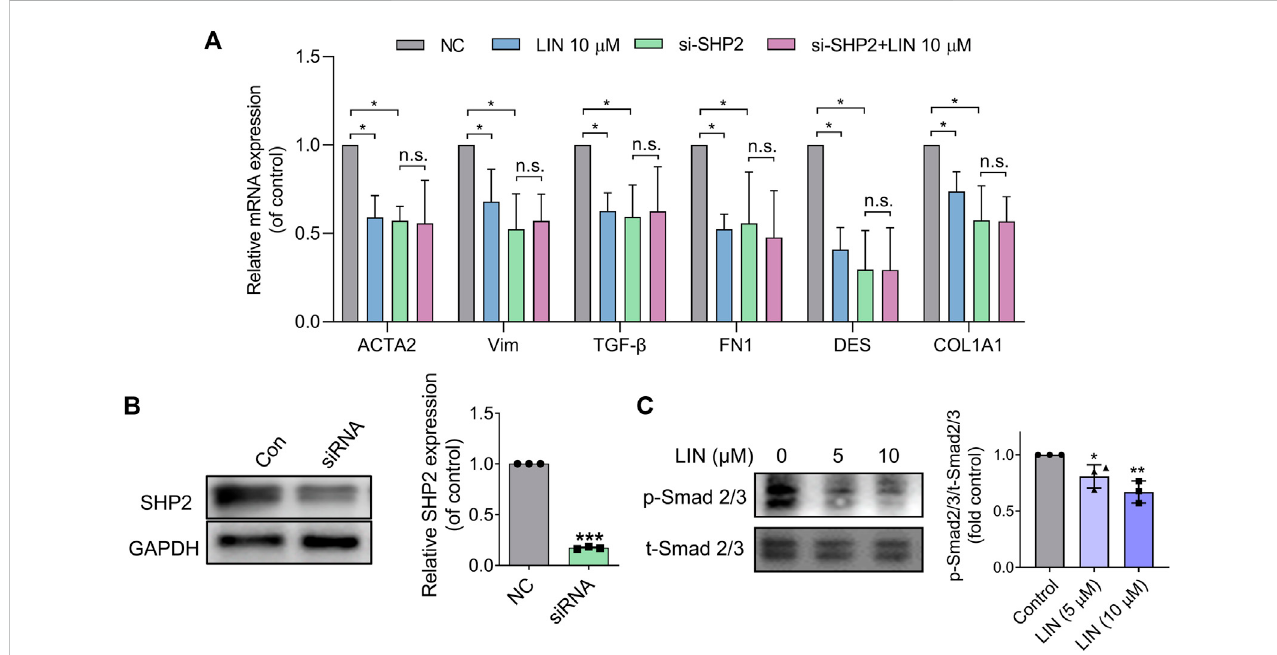
FIGURE 6 LIN suppresses HSCs activation by inhibiting TGF- β /Smad signalling. (A,B) LX-2 cells were transfected with control or SHP2 siRNA (20 pmol/1.0 × 10 5 cells). Twenty-fourhours later, transfected LX-2 cells were treated with LIN at the indicated concentrations. Fibrogenic gene expression levels in LX-2 including ACTA2 , VIM , TGF- β , FN1 , DES , and COL1A1 were evaluated by qPCR. SHP2 levels in siRNA-treated cells were con fi rmed by immunoblotting with anti-SHP2 antibody and qPCR. Experiments were performed in three biological repeats. (C) The expression of p-Smad2/3 and t-Smad 2/3 after LIN treatment (5 and 10 μ M) was detected by